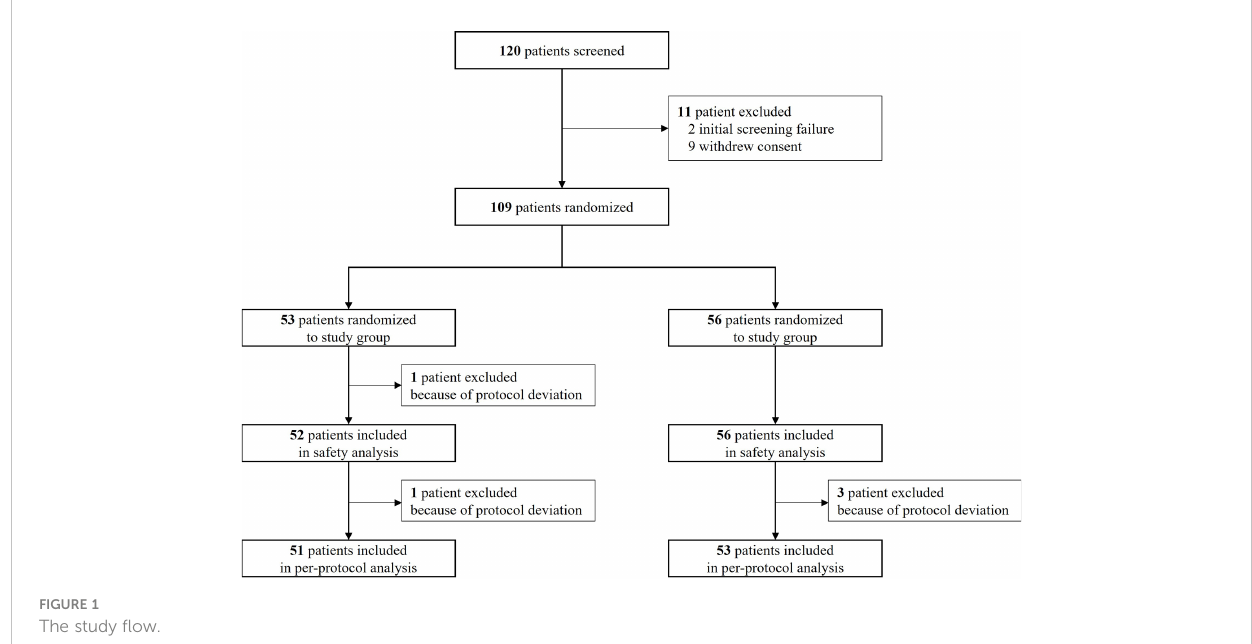
FIGURE 1 The study fl